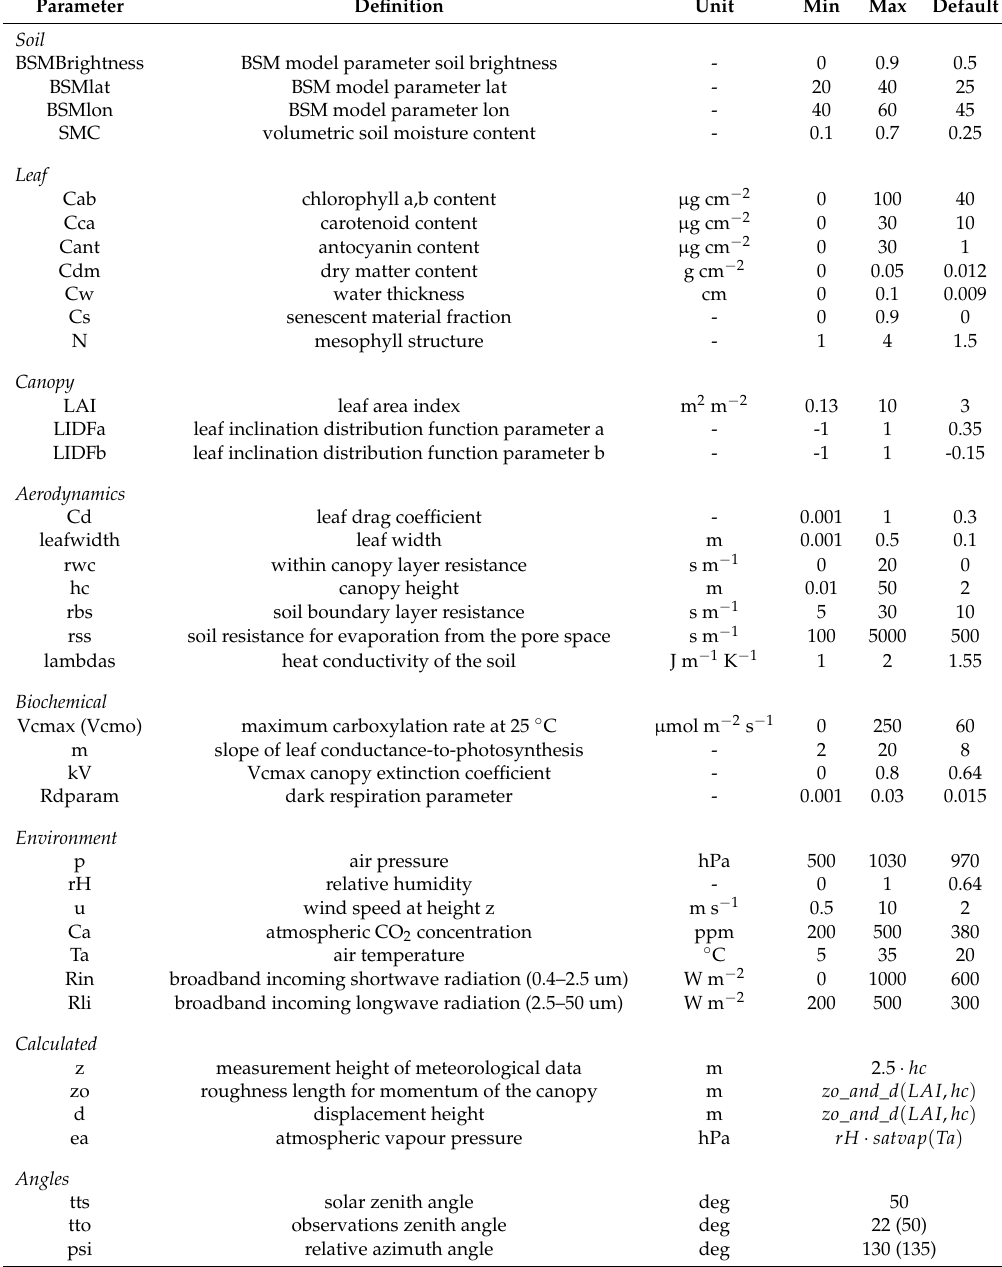
Table 2. Ranges of parameters used in GSA of SCOPE model. Several parameters were calculated. Angles in brackets are related to the oblique view. Fixed SCOPE parameters are listed in Table